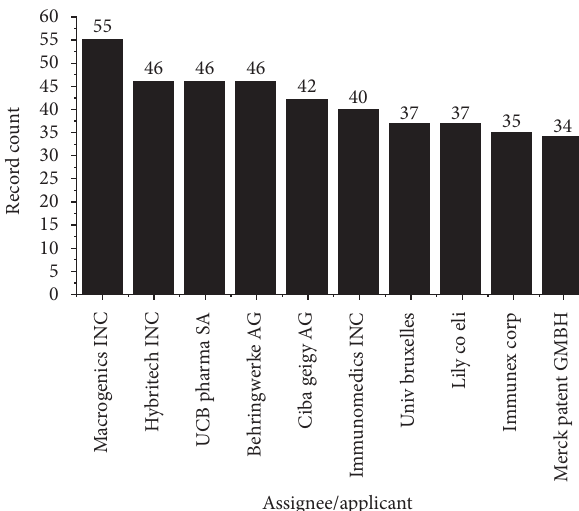
Figure 7: Top 10 assignees/applicants related to the number of record counts.